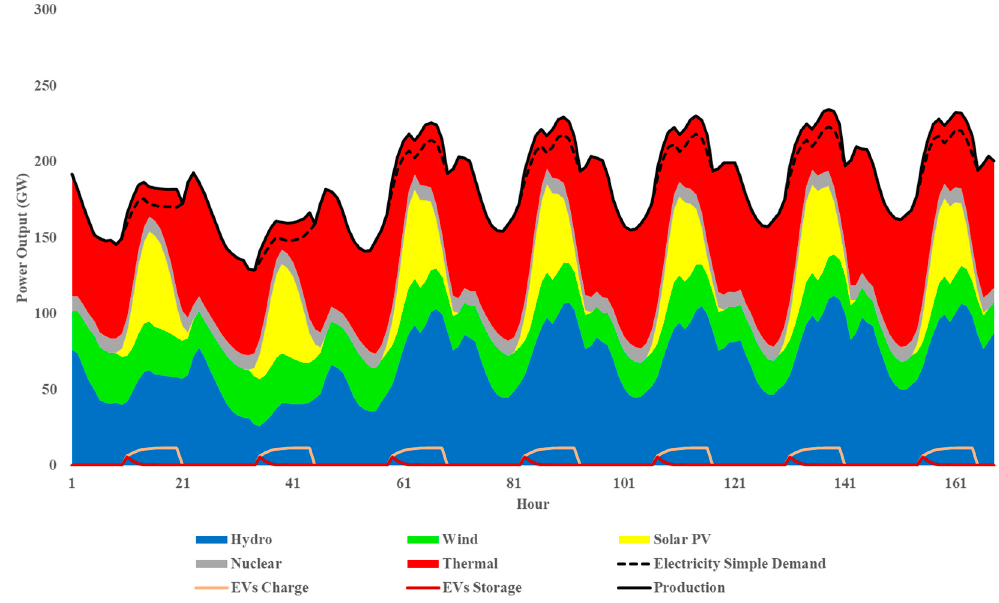
Figure 3. Power output on a spring week for scenario BAU – Daily charging strategy.